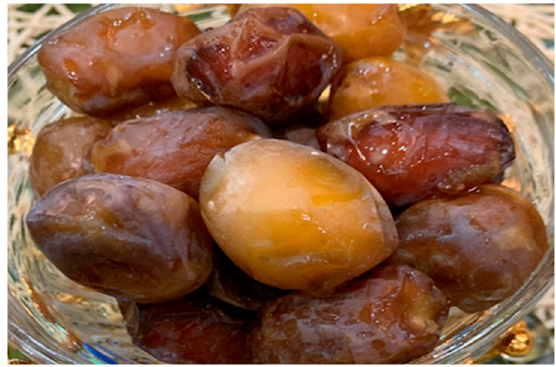
Figure 16. Sample of Al-masyihia dates.